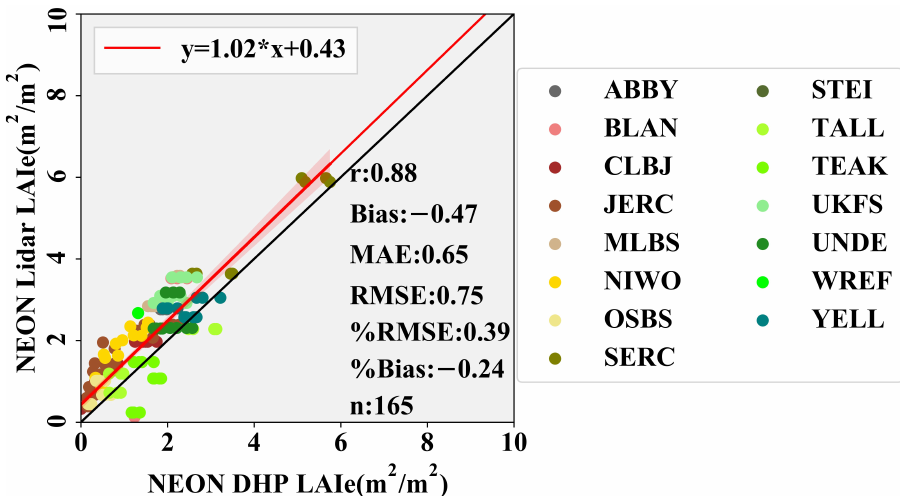
Figure 2. Comparison of NEON Lidar LAIe and NEON DHP LAIe. The bias greater than 0 indicates that NEON Lidar overestimated LAIe compared to DHP LAIe, and vice versa. The black and red solid lines are the 1:1 line and regression line,